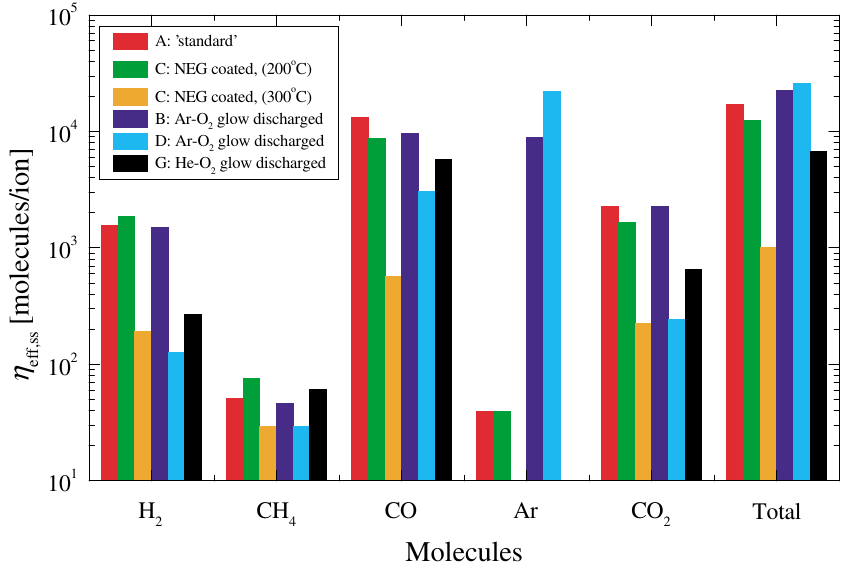
FIG. 7. (Color) Effective desorption yields measured with single shots of 1 : 5 (cid:2) 10 9 Pb 53 (cid:1) ions at 89.2 (cid:7) grazing incidence. The yields were calculated using the ideal gas law and the instantaneous pressure increase due to the single shots. Pumping has been ignored in the calculation; the desorption yields for the NEG-coated chamber C are therefore underestimated.